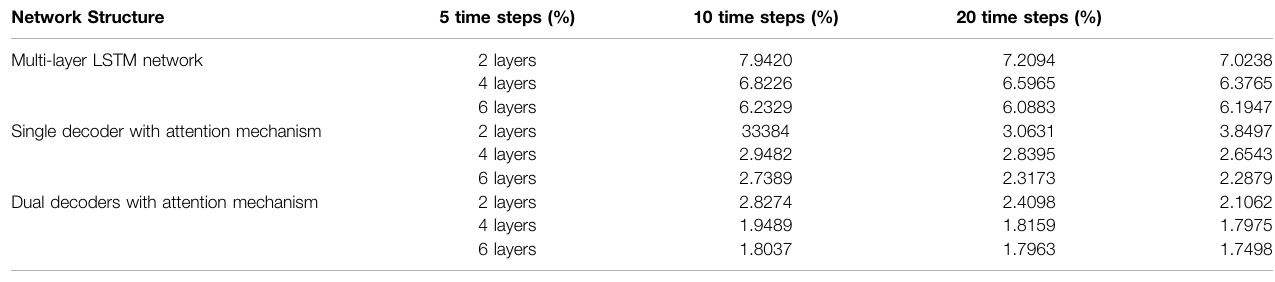
TABLE 2 | The raining errors for different models. Network Structure